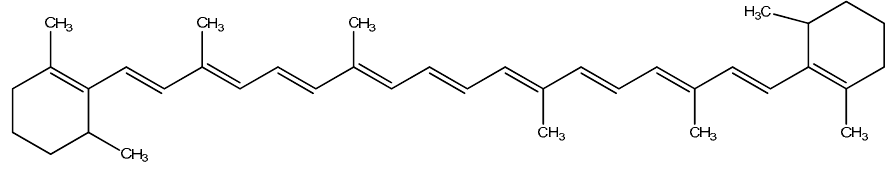
Figure 5. Structure of